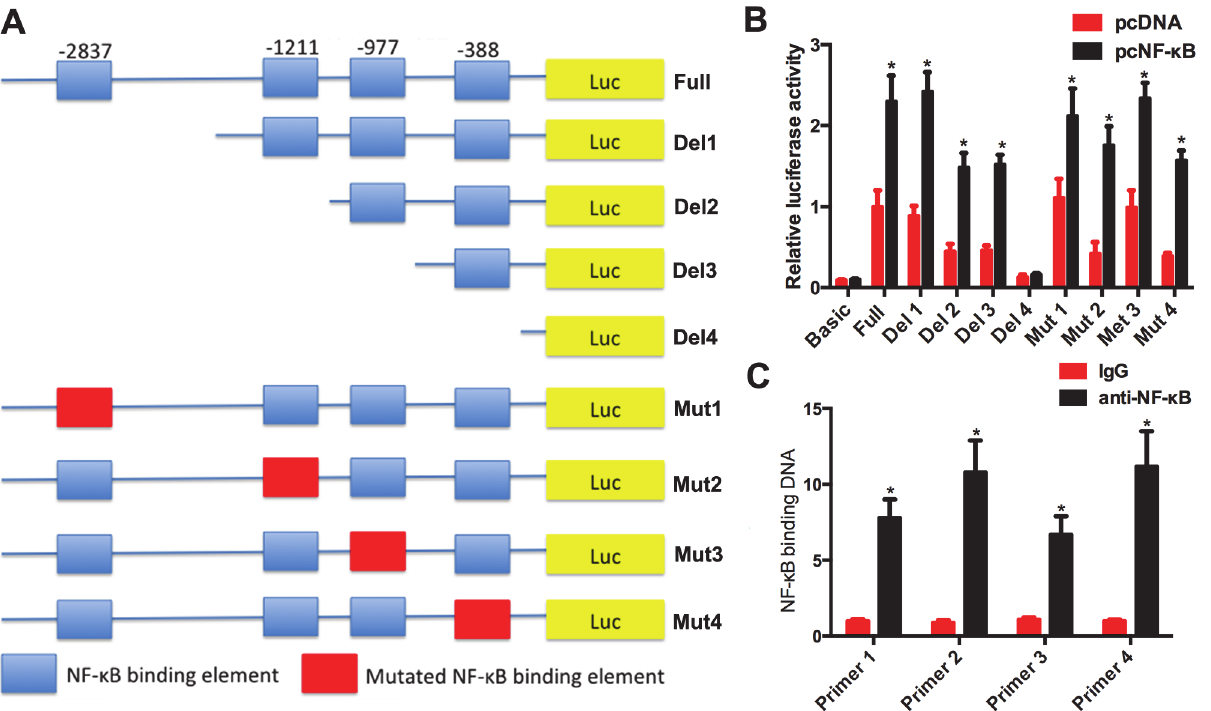
Fig 4. NF- κ B targeting its binding elements in the miR-21 gene promoter. (A) The full length of miR-21 has four NF- κ B binding elements. Different lengths of miR-21 promoter were cloned to pGL4 vector. The four elements were mutated individually and the mutated promoters were also cloned to pGL4 vector. (B) The relative luciferase activity in A549 cells cotransfected with pcNF- κ B and pGL4 reporting vector. (C) ChIP realtime assay showed that NF- κ B antibody bind more DNA than normal IgG. Primer 1 to 4 means the primer contained the four NF- κ B binding elements from upstream to downstream. * P < 0.05 as significant